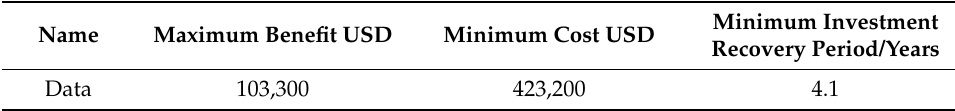
Table 4. Results of economic